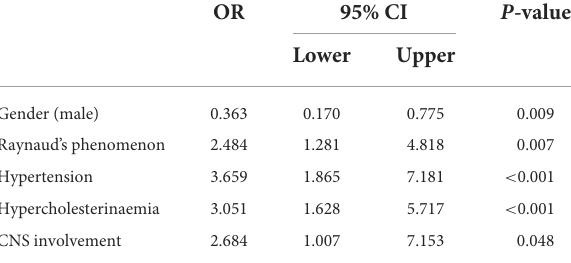
TABLE 3 Predictors of cardiovascular disease, multivariate analysis of gender, Raynaud’s phenomenon, hypertension, hypercholesterolemia, CNS involvement (OR Odds Ratio, CNS central nerve